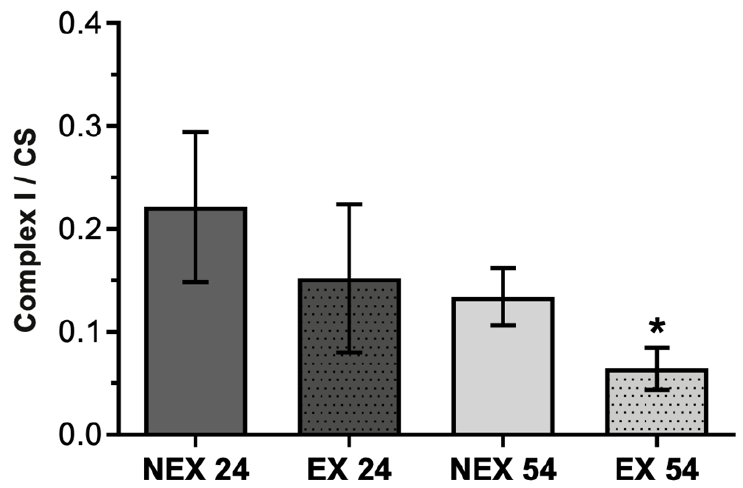
Figure 3. Effect of ageing and training in Complex I/CS. Values are means ± SD ( n = 7), with two replicates. * p < 0.05 compared with NEX24; NEX24 (non-exercising young, sacrifice at 24 weeks of training), EX24 (exercise young, sacrifice at 24 weeks of training), NEX54 (non-exercising middle-age, sacrifice at 54 weeks of training), EX54 (exercise middle-age, sacrifice at 54 weeks of training). NEX54 animals presented a decrease in complex I/CS by 40% compared with young animals (NEX24). Animal training until 32 weeks of age (EX24) diminished the evaluated ratio by 32%. Training until 62 weeks old (EX54) also provoked a statistically significant decrease of 52% compared to young untrained animals ( p = 0.007). 62 weeks of age (Figure 4).